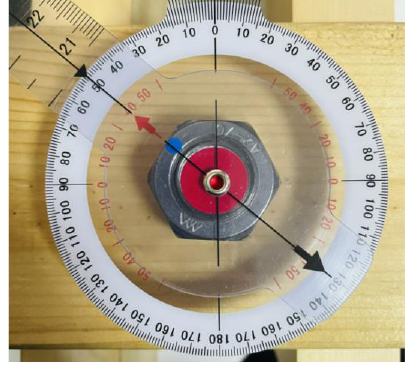
Figure 8. Setup of angle measurement.